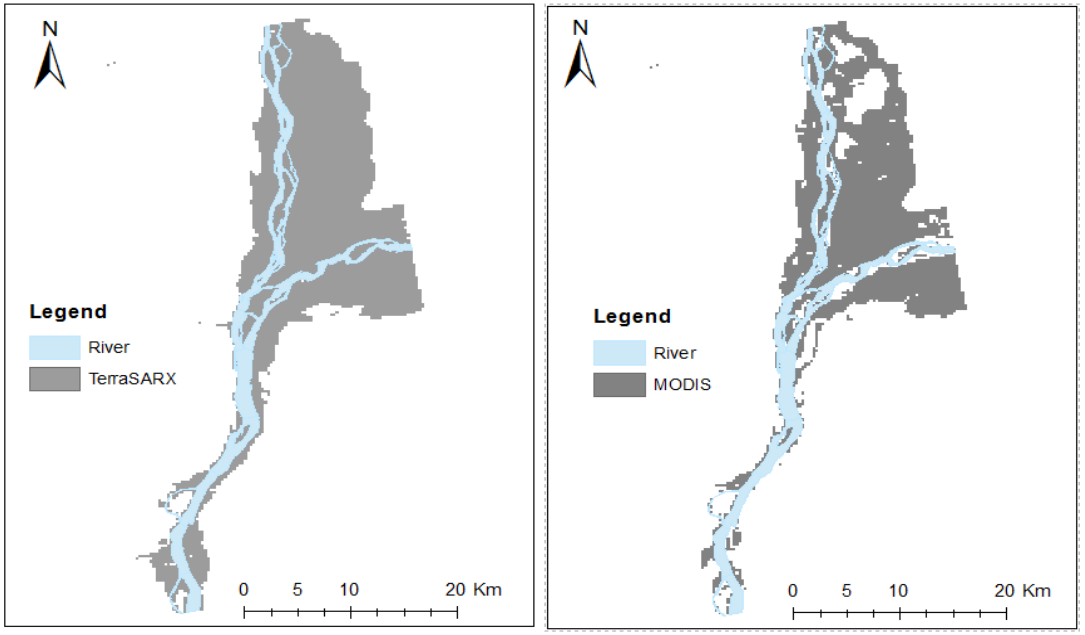
Figure 9. Radar (TerraSAR ‐ X) and optical (MODIS) flood extent comparison at Lokoja, Nigeria.